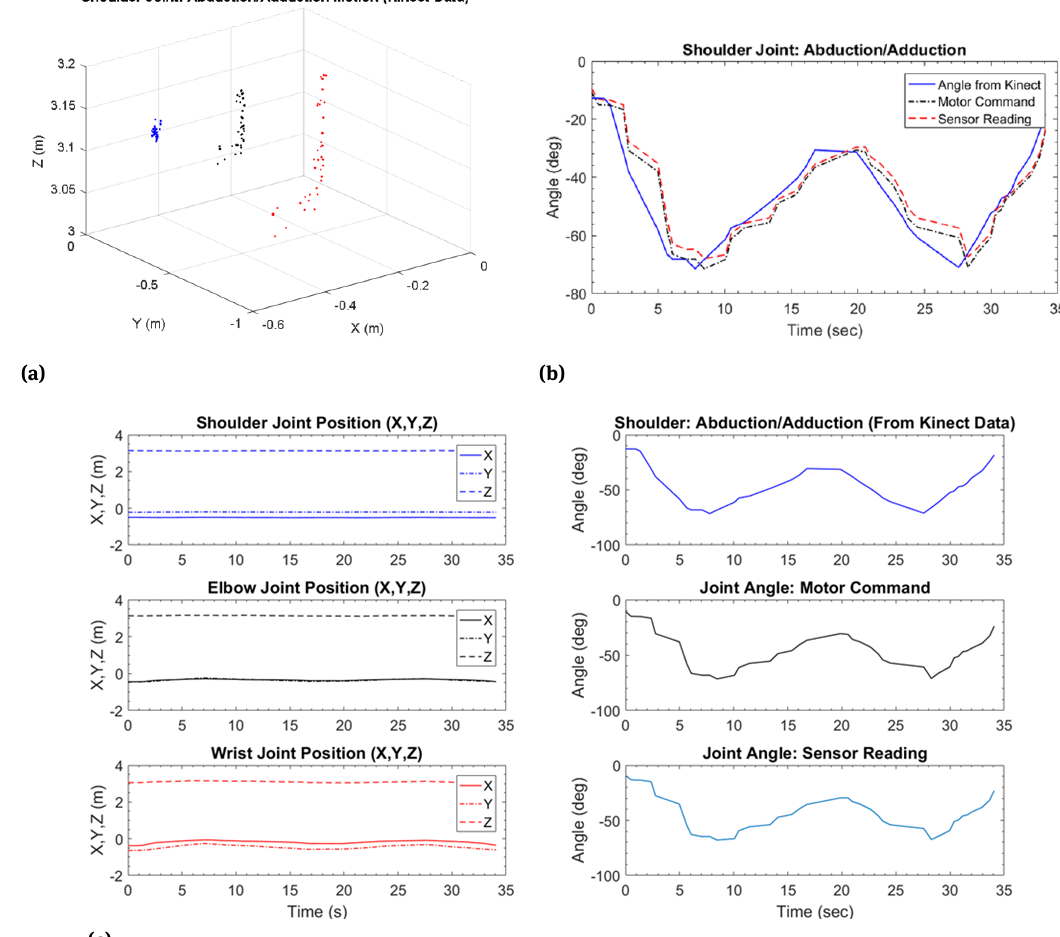
Figure 10: Shoulder joint abduction/adduction teleoperation. (a) Joint coordinate from Kinect; (b) Comparison between the joint angles found from Kinect, and NAO; (c) NAO’s joint angles from Kinect Co-ordinates data